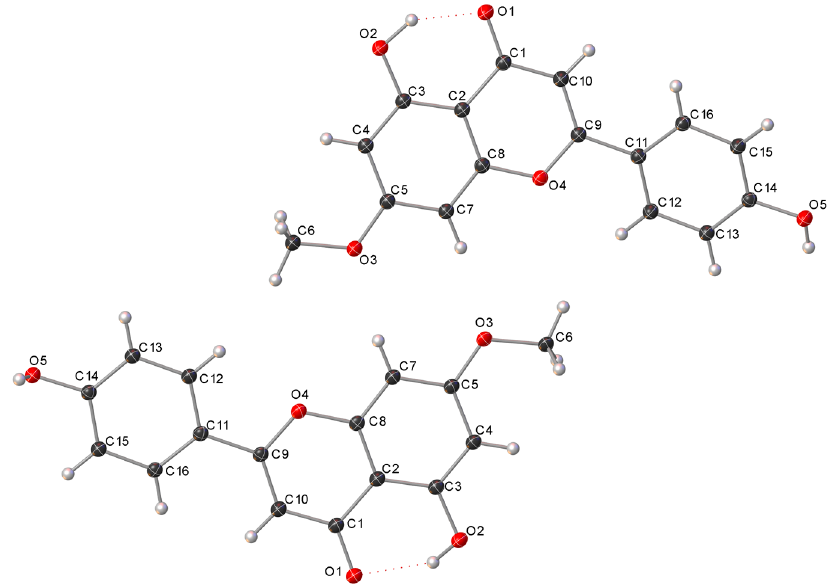
Figure 2. Projections of the two independent Genkwanin molecules ( 1a and 1b ) with their crystallographic